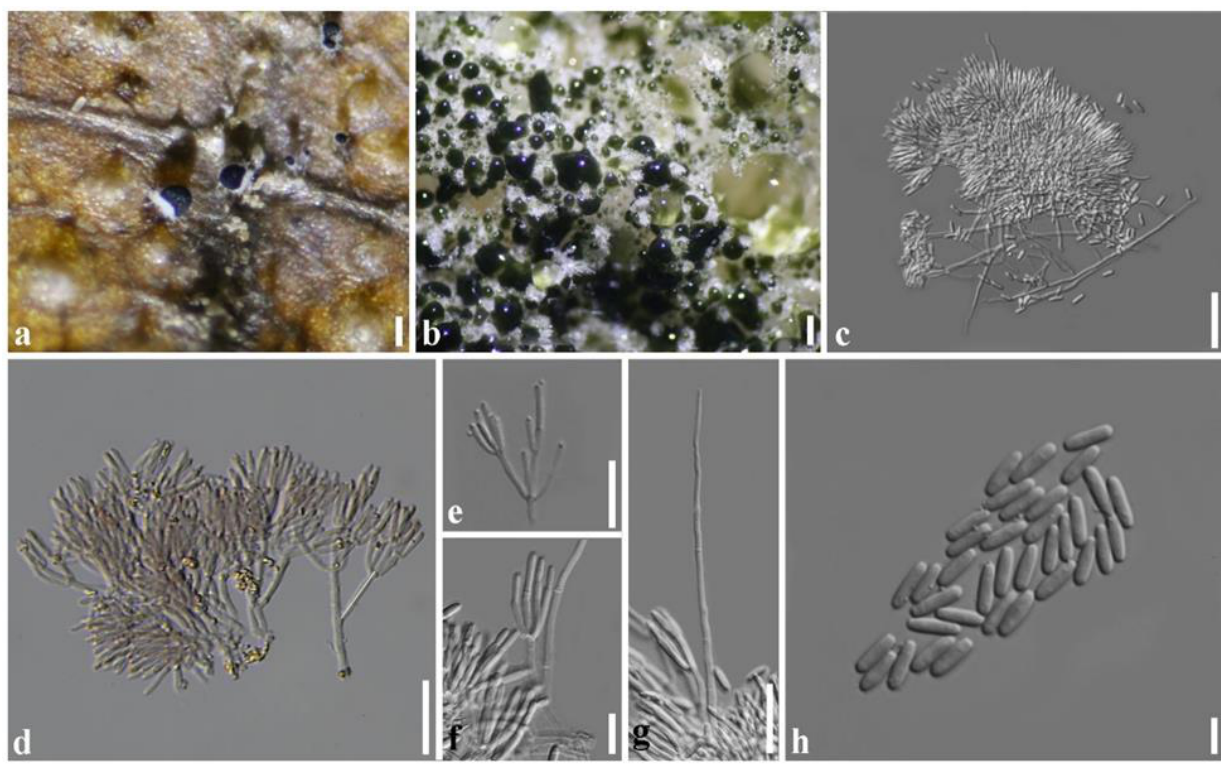
Figure 7. Paramyrothecium foliicola (CRC15); ( a ) sporodochia on leaves of Tectona grandis ( b ) sporodochial conidiomata on PDA; ( c , d ) sporodochia ( e , f ) conidiogenous cells; ( g ) setae; ( h ) condia. Scale bars: ( a ) = 500 µm; ( b ) = 1 mm; ( c ) = 30 µm; ( d , g ) = 20 µm; ( h ) = 5 µm. Description: Sexual morph: unknown. Asexual morph: Conidiomata